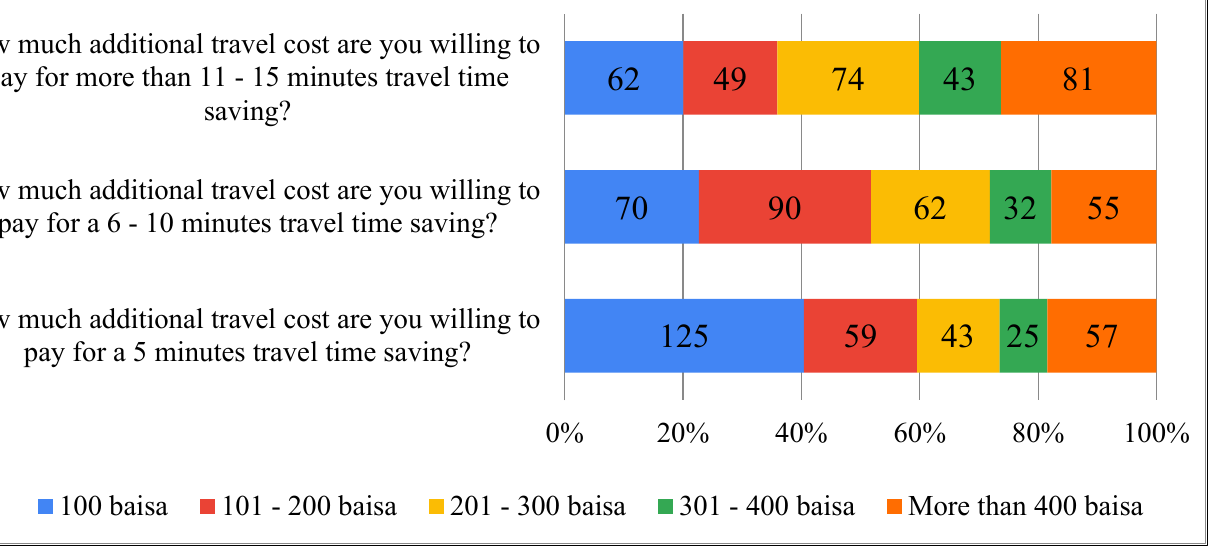
Figure 4. Distribution of willingness to pay for various levels of travel time saving.